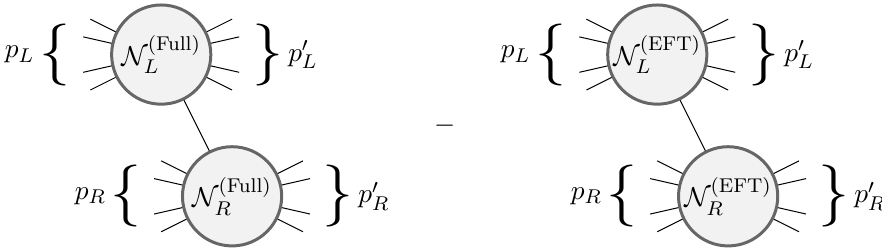
Figure 2 . Schematic representation of a “tree” iteration subtraction contribution to the effective potential. In a physically acceptable representation of the potential, the spurious matter pole must cancel between full-theory and